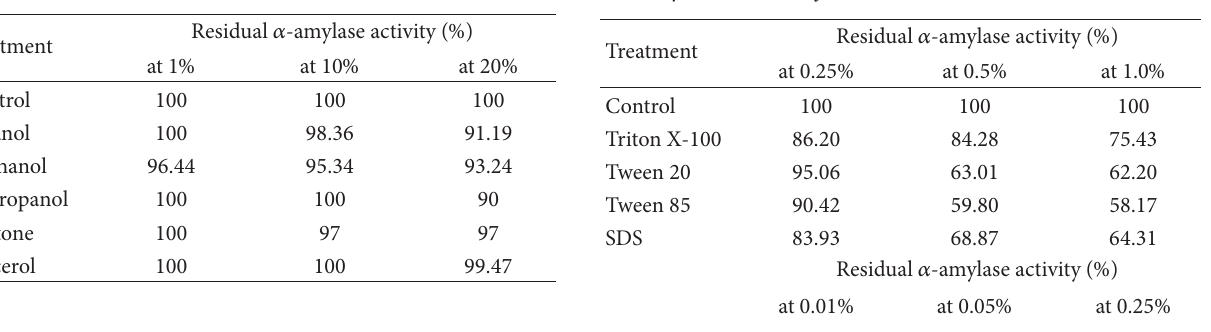
T 6: Effect of different detergents, anionic surfactant, and chelating agents on the puri�ed -amylase enzyme activity pro- duced by Bacillus licheniformis AI20.